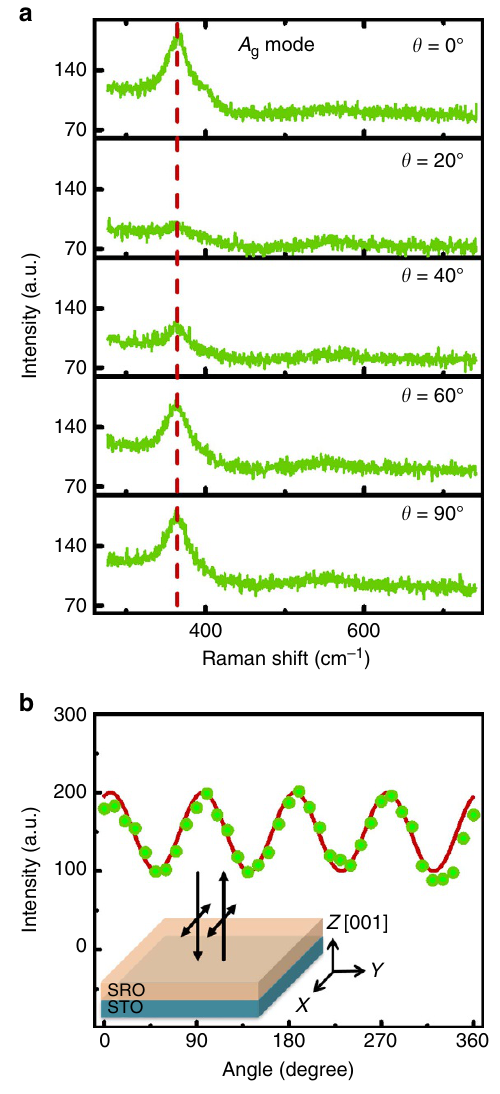
Figure 1 | Polarization-dependent Raman scattering. ( a ) Raman spectra of the A g phonon mode recorded at the rotation angle, y , of an (001)-oriented SrRuO 3 thin film epitaxially grown on an (001) SrTiO 3 substrate. The vertical dashed lines indicate the positions of the A g phonon modes of SrRuO 3 . ( b ) The rotation angle dependence of the intensity of the A g phonon mode at 372cm (cid:3) 1 . The solid line represents the best fit to the calculated intensity of the A g phonon mode. The inset shows the normal backscattering geometry used in the polarized Raman scattering system. The arrow represents the propagation and polarization directions of the incident and scattered light, respectively.